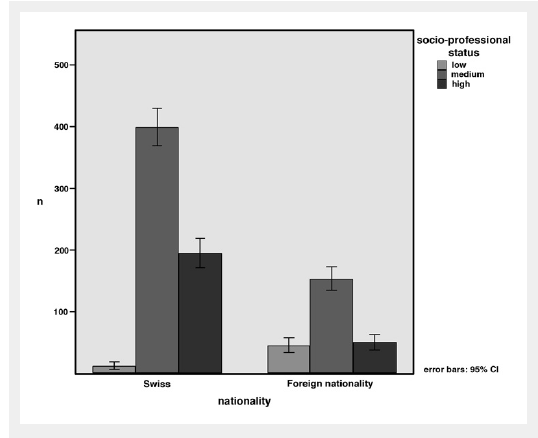
Socio-professional status in relation to nationality (p <0.001, chi- square